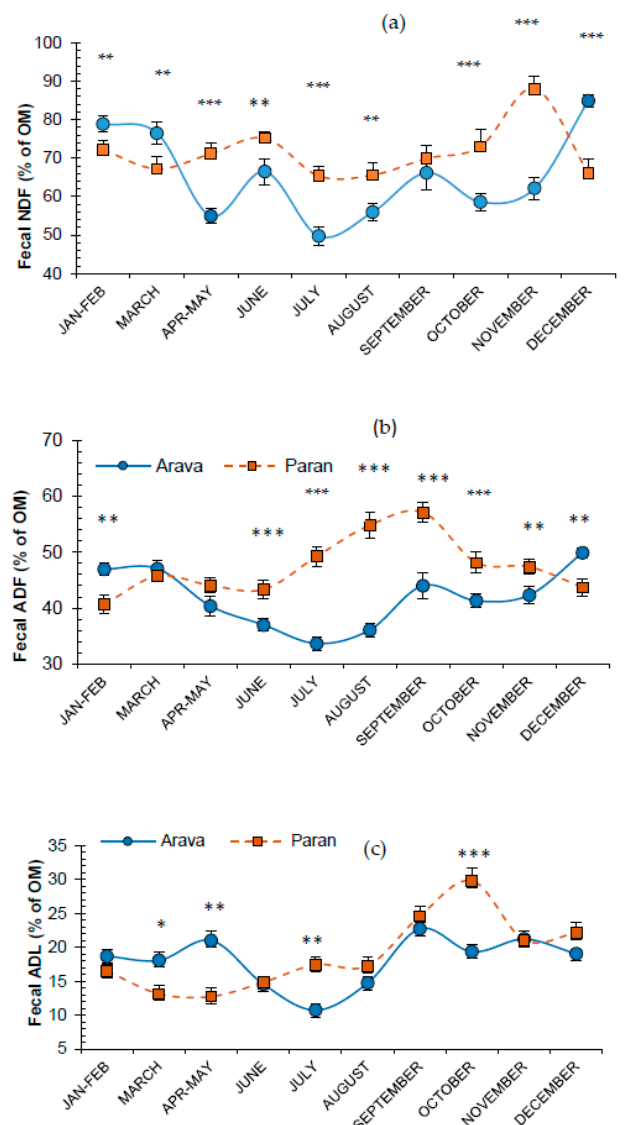
Figure 6. Concentrations of ( a ) neutral detergent fiber (NDF; % of organic matter); ( b ) acid detergent fiber (ADF, % of organic matter); and ( c ) acid detergent lignin (c; % of organic matter) in the feces of oryx released at the Arava and Paran sites: monthly averages and SE. *** p < 0.001; ** p < 0.01; * p <